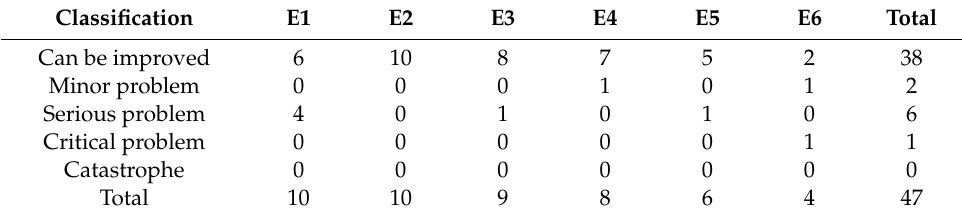
Table 5. Number of problems and their classification by expert.